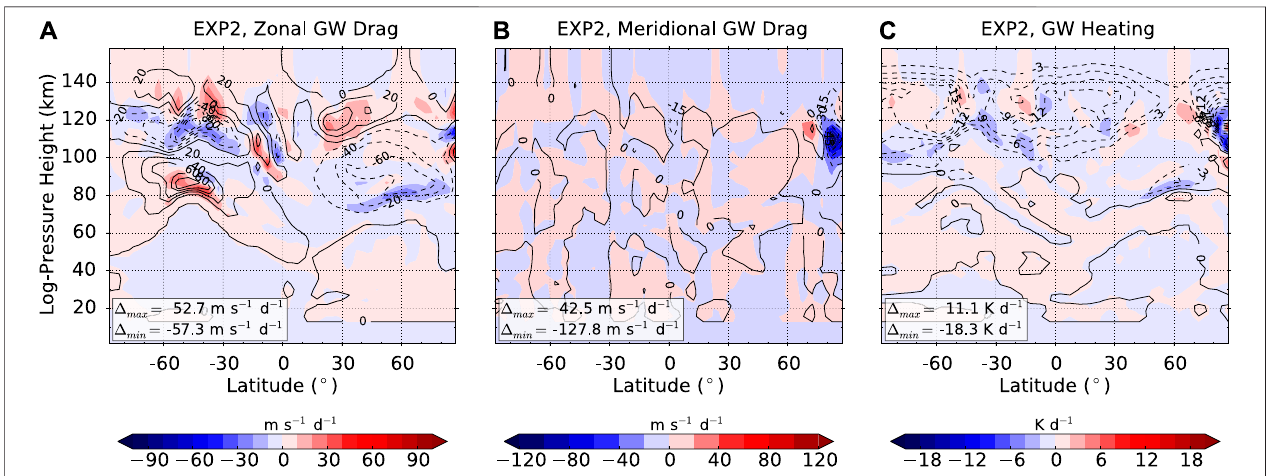
FIGURE5| Sameas Figure4 butfor (A) zonalGWdrag, (B) meridionalGWdragand (C) heatingduetoGWsinintervalsof (A) 20 m s − 1 d − 1 , (B) 15m s − 1 d − 1 and (C) 3 K d − 1 . Color shading: differences